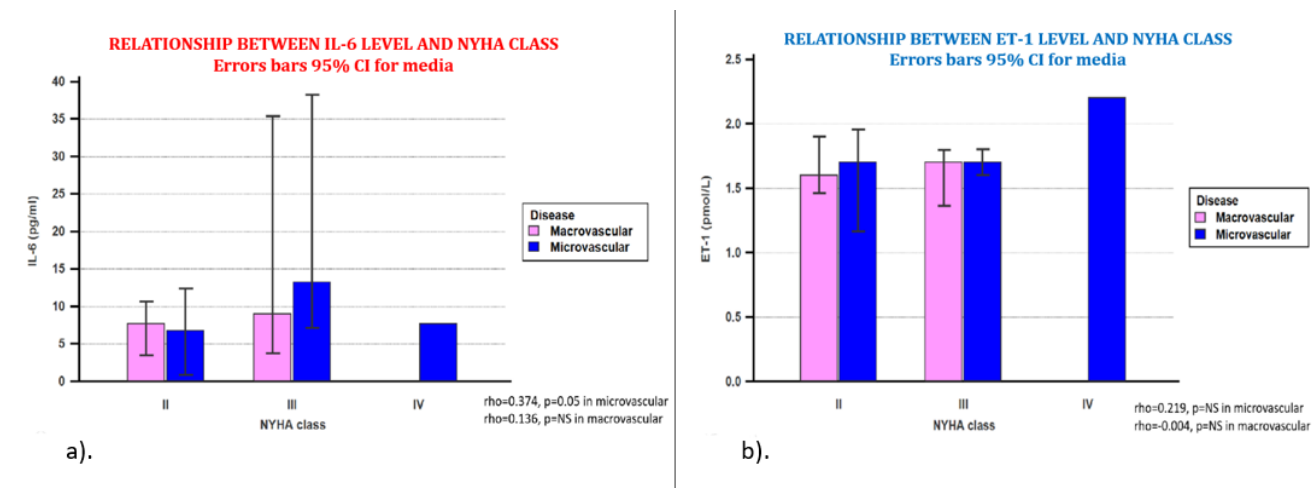
Figure 4. ( a ). Relationship between IL-6 value and NYHA functional class comparatively between the two groups. The increased value of IL6 was directly associated with NYHA functional class, but only for patients with microvascular angina, not for those with coronary heart disease. ( b ). Relationship between ET-1 level and NYHA functional class comparatively between the two groups. The ET1 value was not correlated with the NYHA functional class, regardless of the type of coronary heart disease, microvascular or macrovascular. NYHA class — New York Heart Association, Functional Classification.